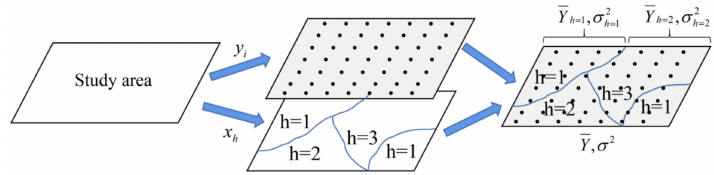
Figure 3. The principle of a geographical